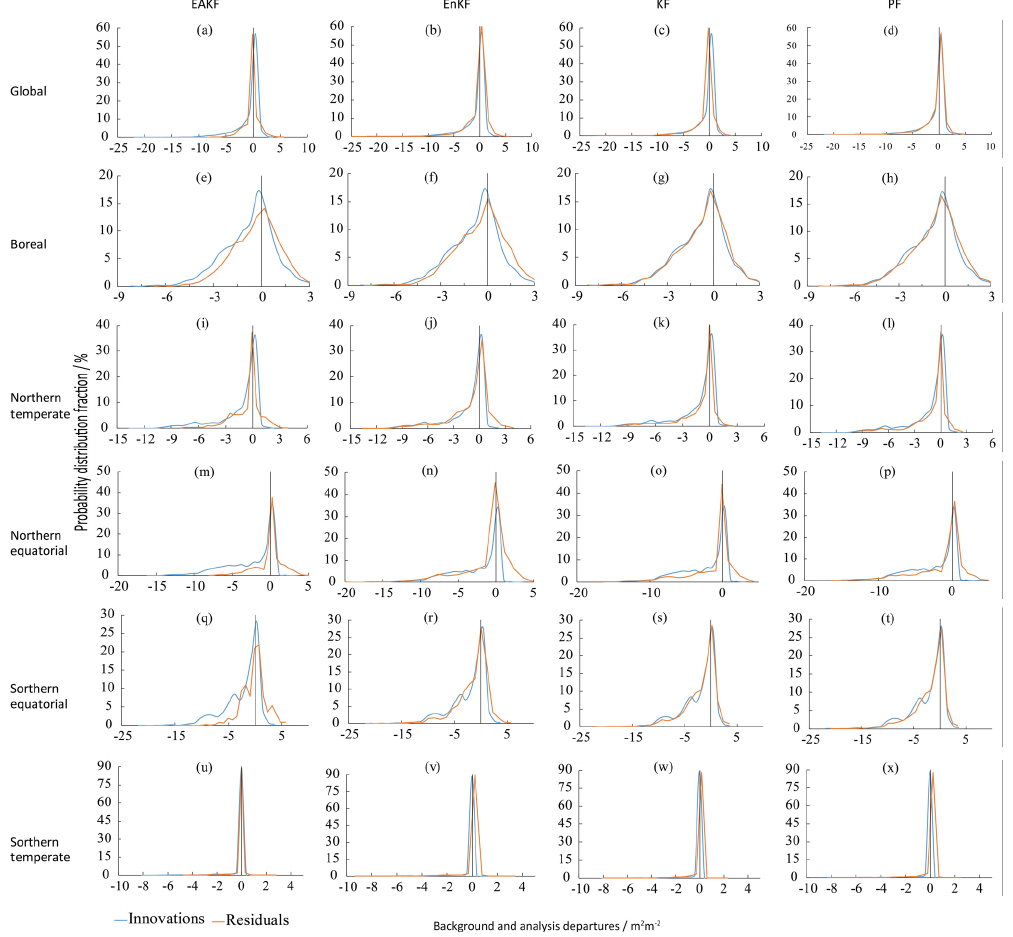
Figure 6. The histograms of innovation and residuals of LAI globally and for all subregions during July 2002. (a–d) Global; (e–h) boreal; (i–l) northern temperate; (m–p) northern equatorial; (q–t) southern equatorial; (u–x) southern